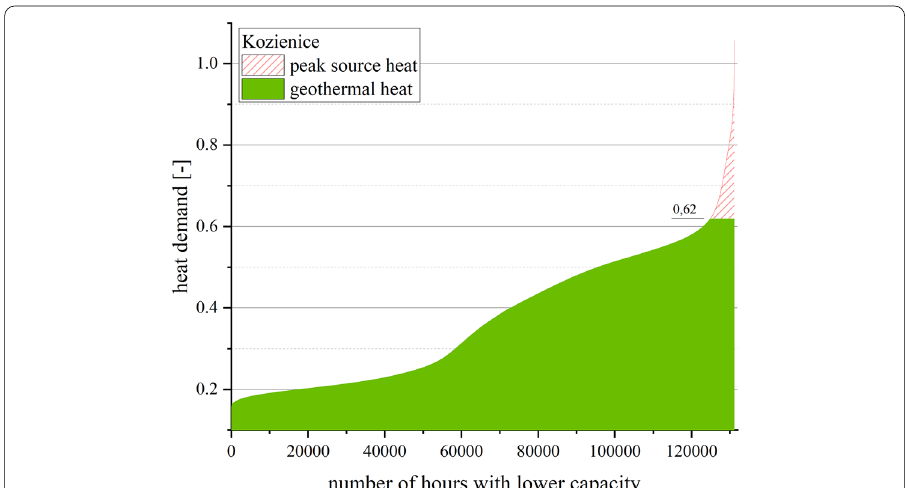
Fig. 5 Normalised heat demand duration curve. The filled areas represent demand covered by geothermal heat source (solid green) and peak heat source (dashed red). The cut-off value for geoDH peak source was assessed to be about 62% of nominal heat demand (according to Eq. 2